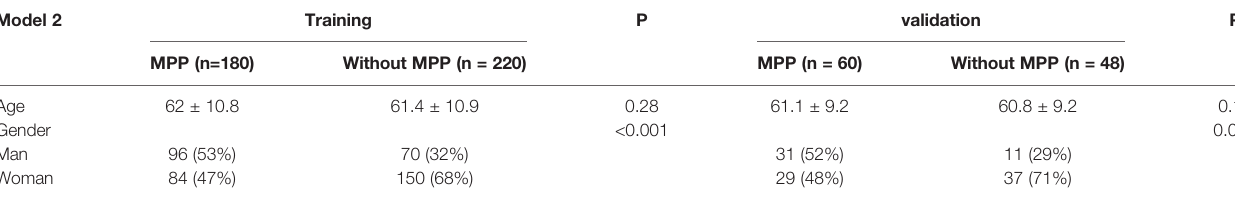
TABLE 2 | Demographic and clinical characteristics of patients on different datasets of model 2.